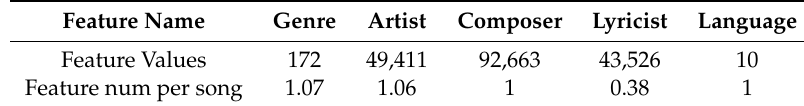
Table 4. Feature statistics of